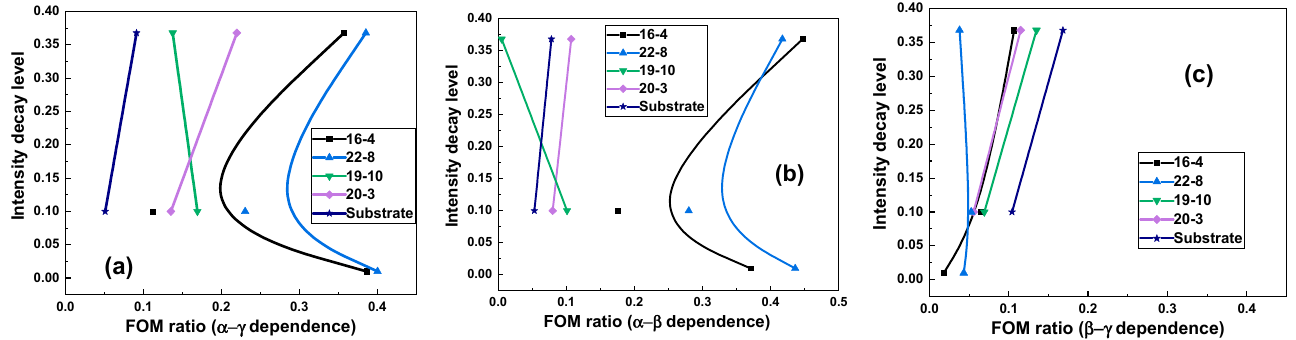
The results presented in Figure 12 demonstrate that that the highest FOM αγ of up to 0.38 and highest FOM αβ of up to 0.44 were obtained with the Lu 1.5 Gd 1.5 -substituted films, which seem promising for these discrimination tasks. FOM βγ did not exceed 0.13 (the highest value was again registered in the Tb 2 Gd-substituted films).